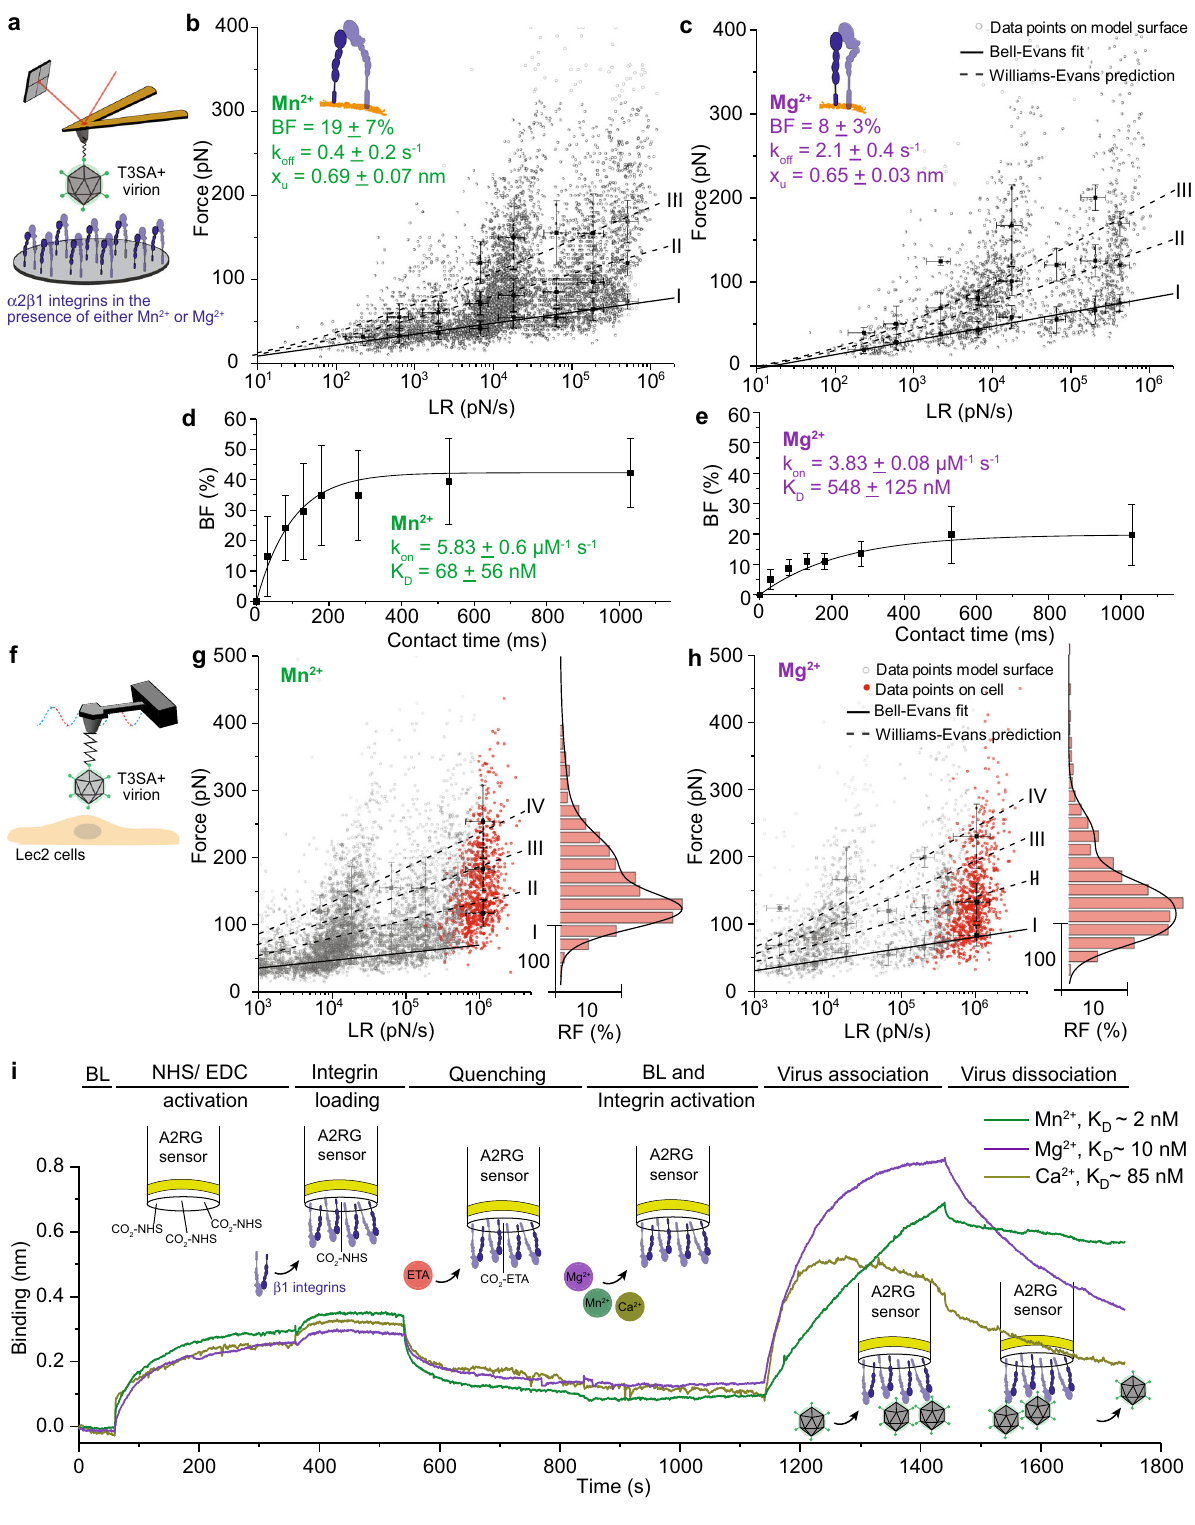
approaches: AFM studies using model surfaces (Fig. 3b, c) and living cells (Fig. 3g, h) and biolayer interferometry (BLI) (Fig.